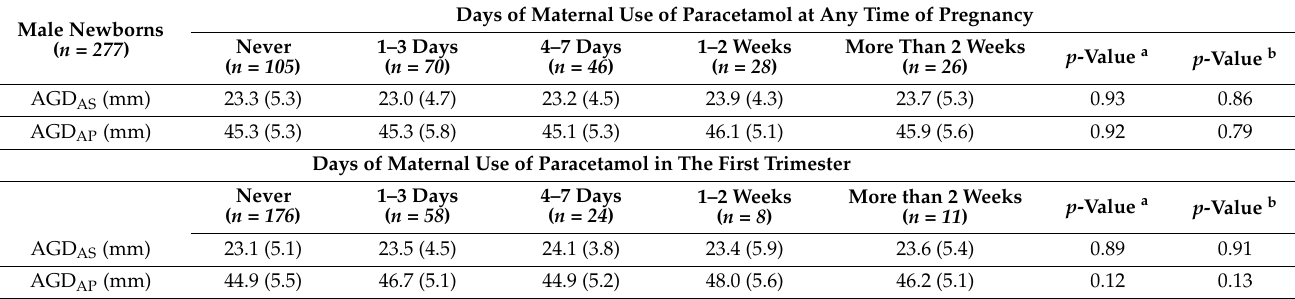
AGD AS : anogenital distance from the anus to the posterior base of the scrotum; AGD AP : anogenital distance from the anus to the cephalad insertion of the penis. a ANOVA test. AGDs were transformed into Z-scores. b ANCOVA test. AGDs were transformed into Z-scores. Models adjusted by previous pre-term deliveries and gestational